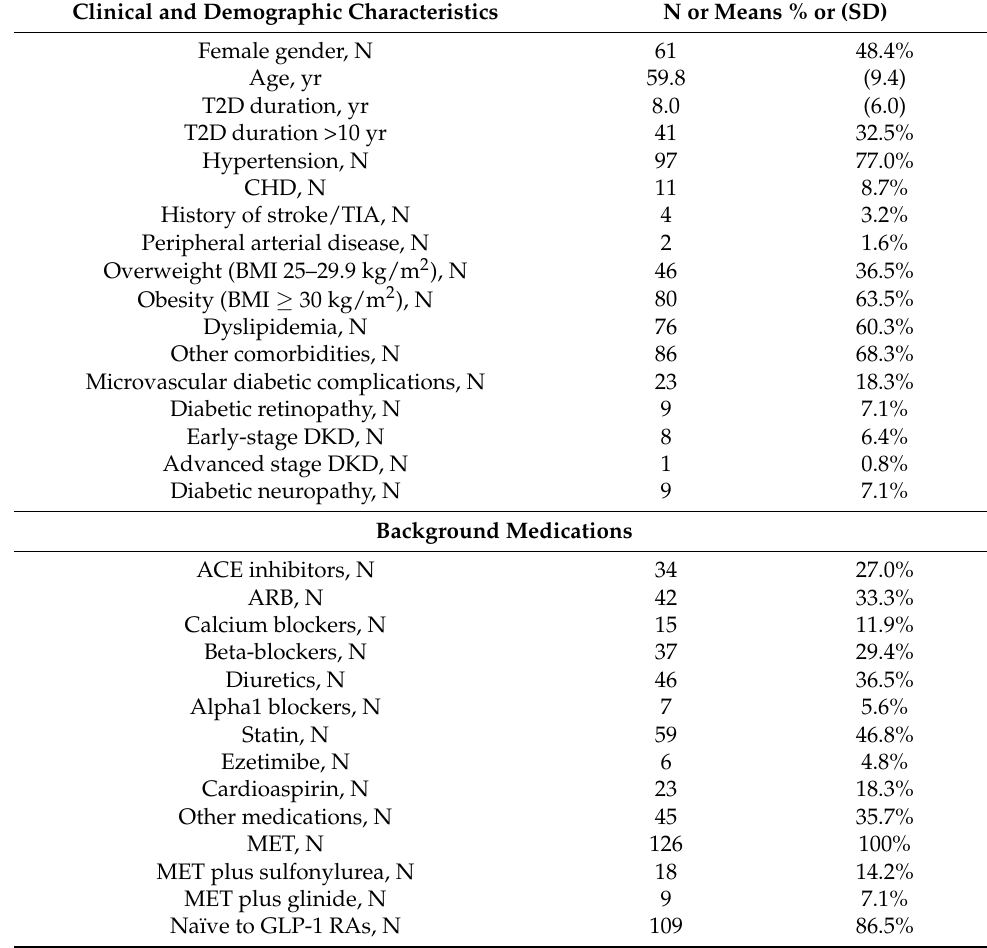
Table 1. Baseline clinical and demographic characteristics of the cohort of overweight or obese type 2 diabetes (T2D) patients eligible for the primary analysis (N = 126) with at least one prescription of dulaglutide 1.5 mg/once weekly as add-on to metformin (MET) or MET plus conventional insulin